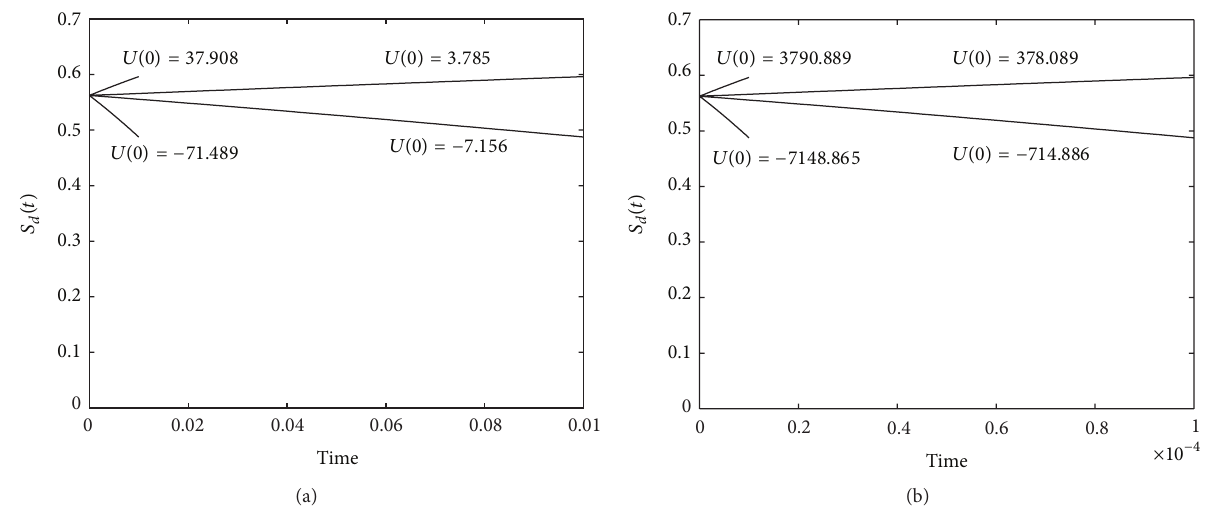
𝑇 , when 𝑆 𝑑 (𝑇) = 0.6 and 0.5, 𝑇 = 0.01 , 0.001, 0.0001,